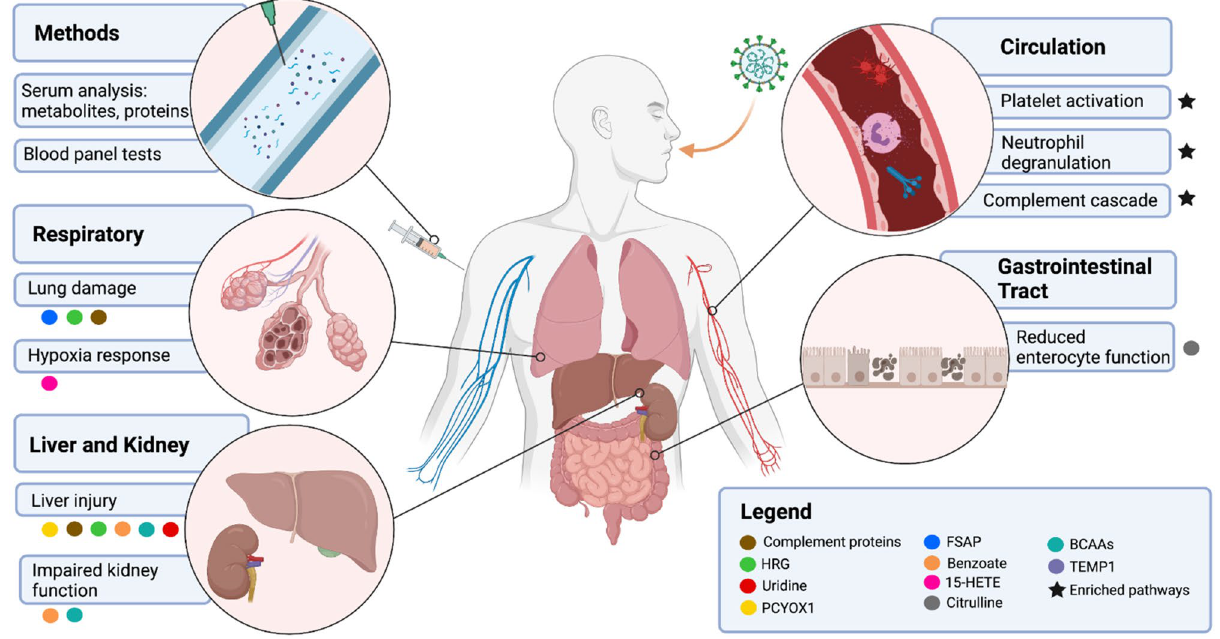
Figure 1. Systemic drivers of COVID-19 associated inflammation. COVID-19 begins as a respiratory tract infection that targets the lung epithelium, but in many severe cases, as the disease progresses, clinical manifestations can span the entire body as a result of systemic inflammation. This includes multisystem abnormalities in biological processes and metabolic functions that may exacerbate the inflammatory response observed in severe cases. An integrated analysis of proteomics and metabolomics data collected from a cohort presenting a range of COVID-19-related health outcomes led to the identification of potential biomarkers within the lungs, liver, gastrointestinal tract, kidneys, and peripheral blood. This analysis provides a deeper resolution of the possible molecular determinants of COVID-19-associated inflammation that are worthy of further investigation. This figure was created with